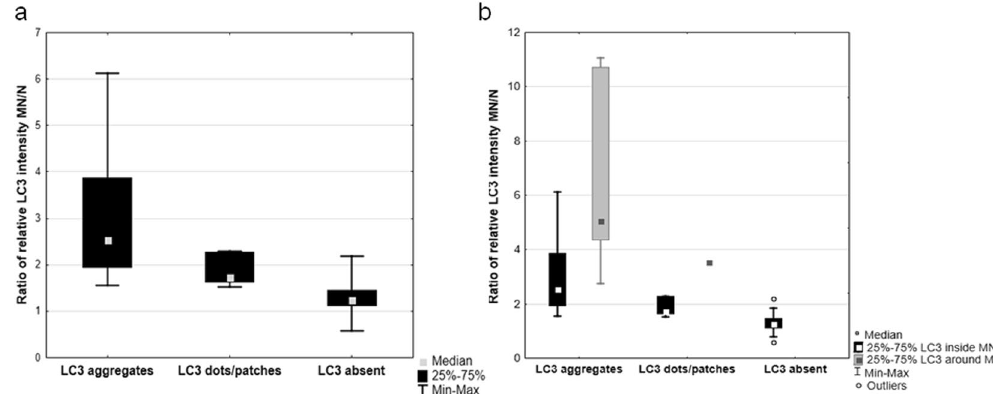
Figure 8. Quantitative analysis of LC3 autophagosome marker presence in micronuclei. ( a ) Ratios of LC3 relative fluorescence of micronuclei (MN) to main nuclei (N) according to 3 classes of LC3 distribution (aggregates, dots/patches, absent) in gonocytes of hybrid frogs. ( b ) Ratios of LC3 relative fluorescence of micronuclei (MN) to main nuclei (N) in gonocytes of hybrid frogs. In case of LC3 aggregates and